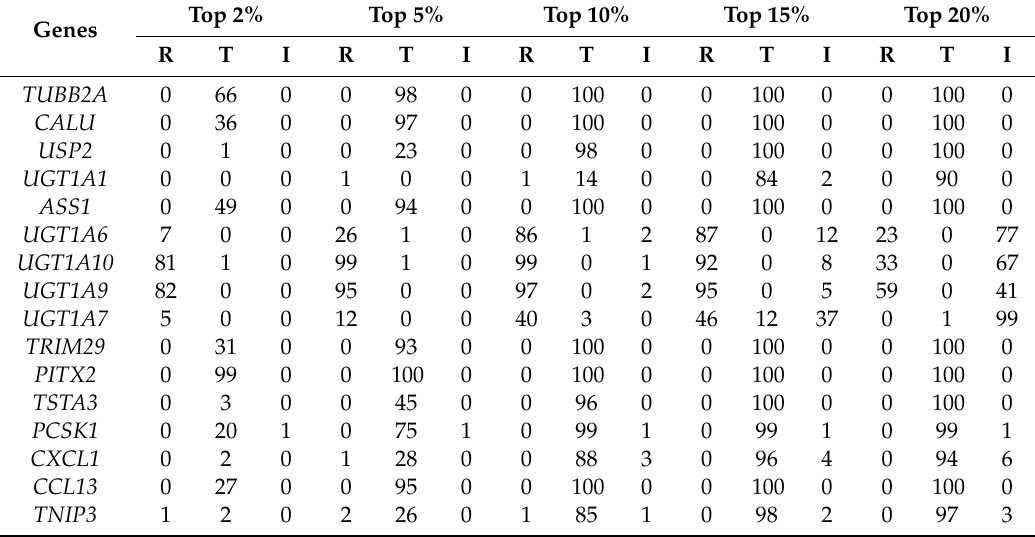
Table 1. Frequencies of di ff erent genes appearing as Regulatory (R), Target (T), or Intermediate (I) gene for di ff erent threshold values for the IBD data. For each threshold value, the experiment was executed 100 times with the same set of parameter values.